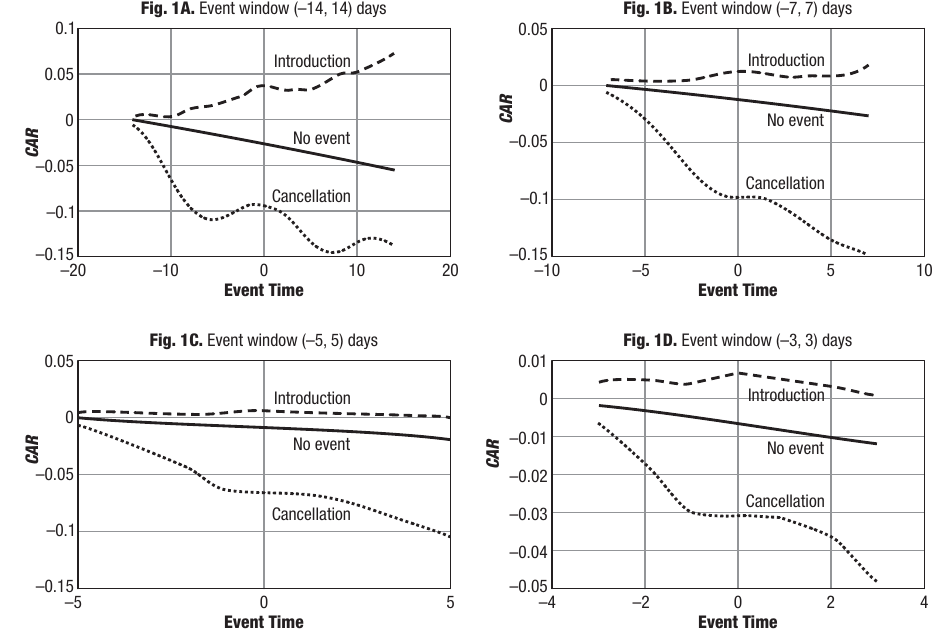
Fig . 1A . Event window ((cid:2)14,14) days Fig . 1 . B Event window ((cid:2) , ) days7 7